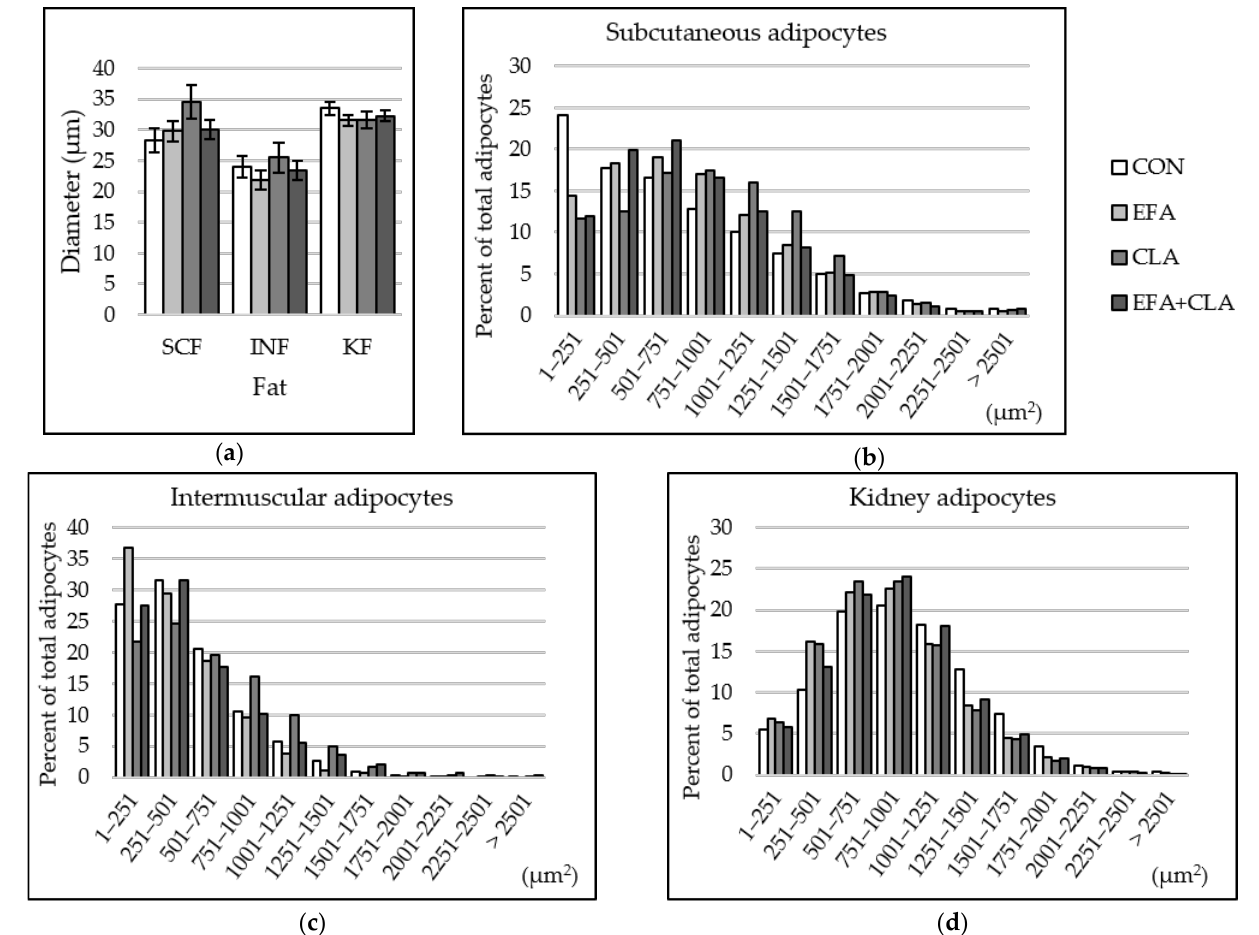
Figure 6. Fat cell size distribution in subcutaneous (SCF), intermuscular (INF) and kidney (KF) fat of calves of four maternal supplementation groups: Control group (CON, n = 8), essential fatty acids (EFA, n = 9), conjugated linoleic acids (CLA, n = 8), EFA + CLA (n = 11). ( a ) Fat cell diameter ( µ m). Data are shown as LSM ± SE LSM . ( b – d ) Percentage of adipocytes per size category ( µ m 2 ) in ( b ) SCF, ( c ) INF, ( d )